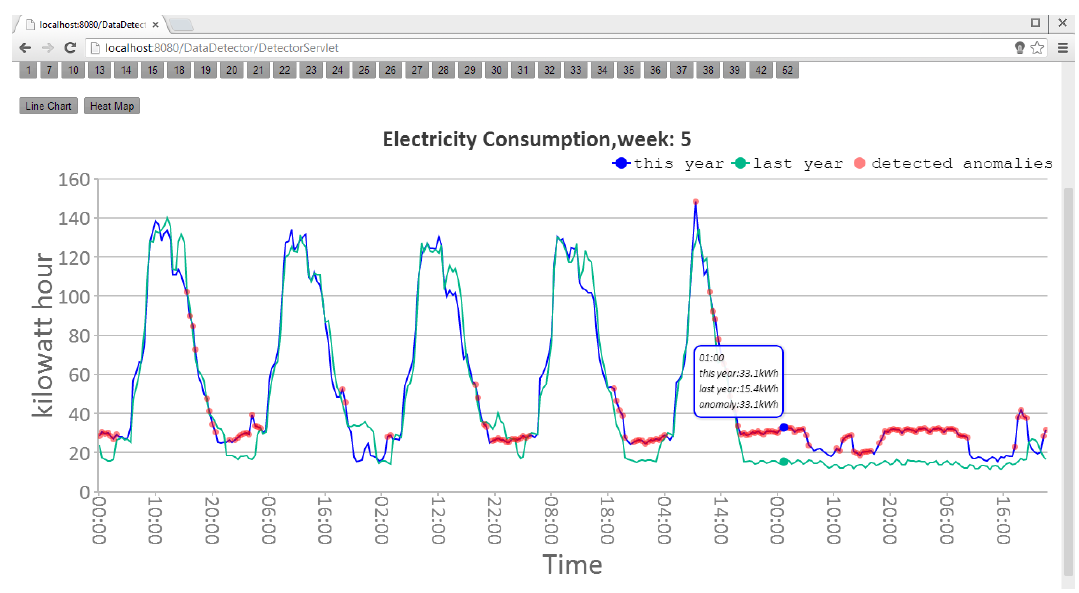
Figure 14. The line chart of the 5th week’s electricity consumption data of a school [8].